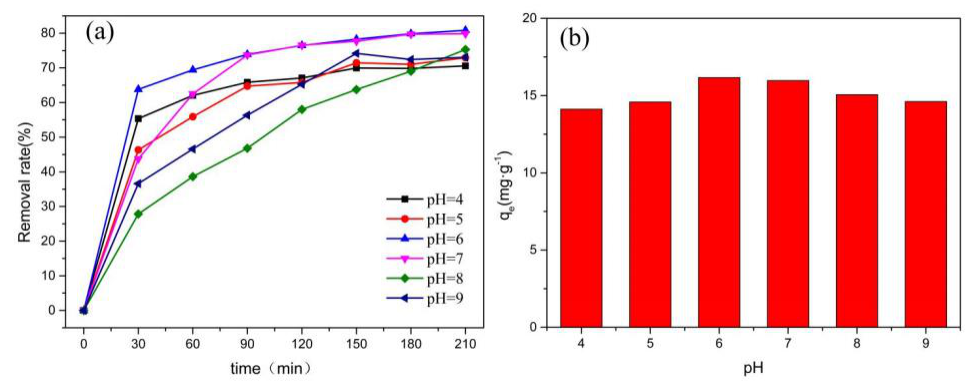
Figure 5. Adsorption rate of ciprofloxacin on CoO@C-500 at different pH conditions ( a ) and equilibrium adsorption capacities ( b ).